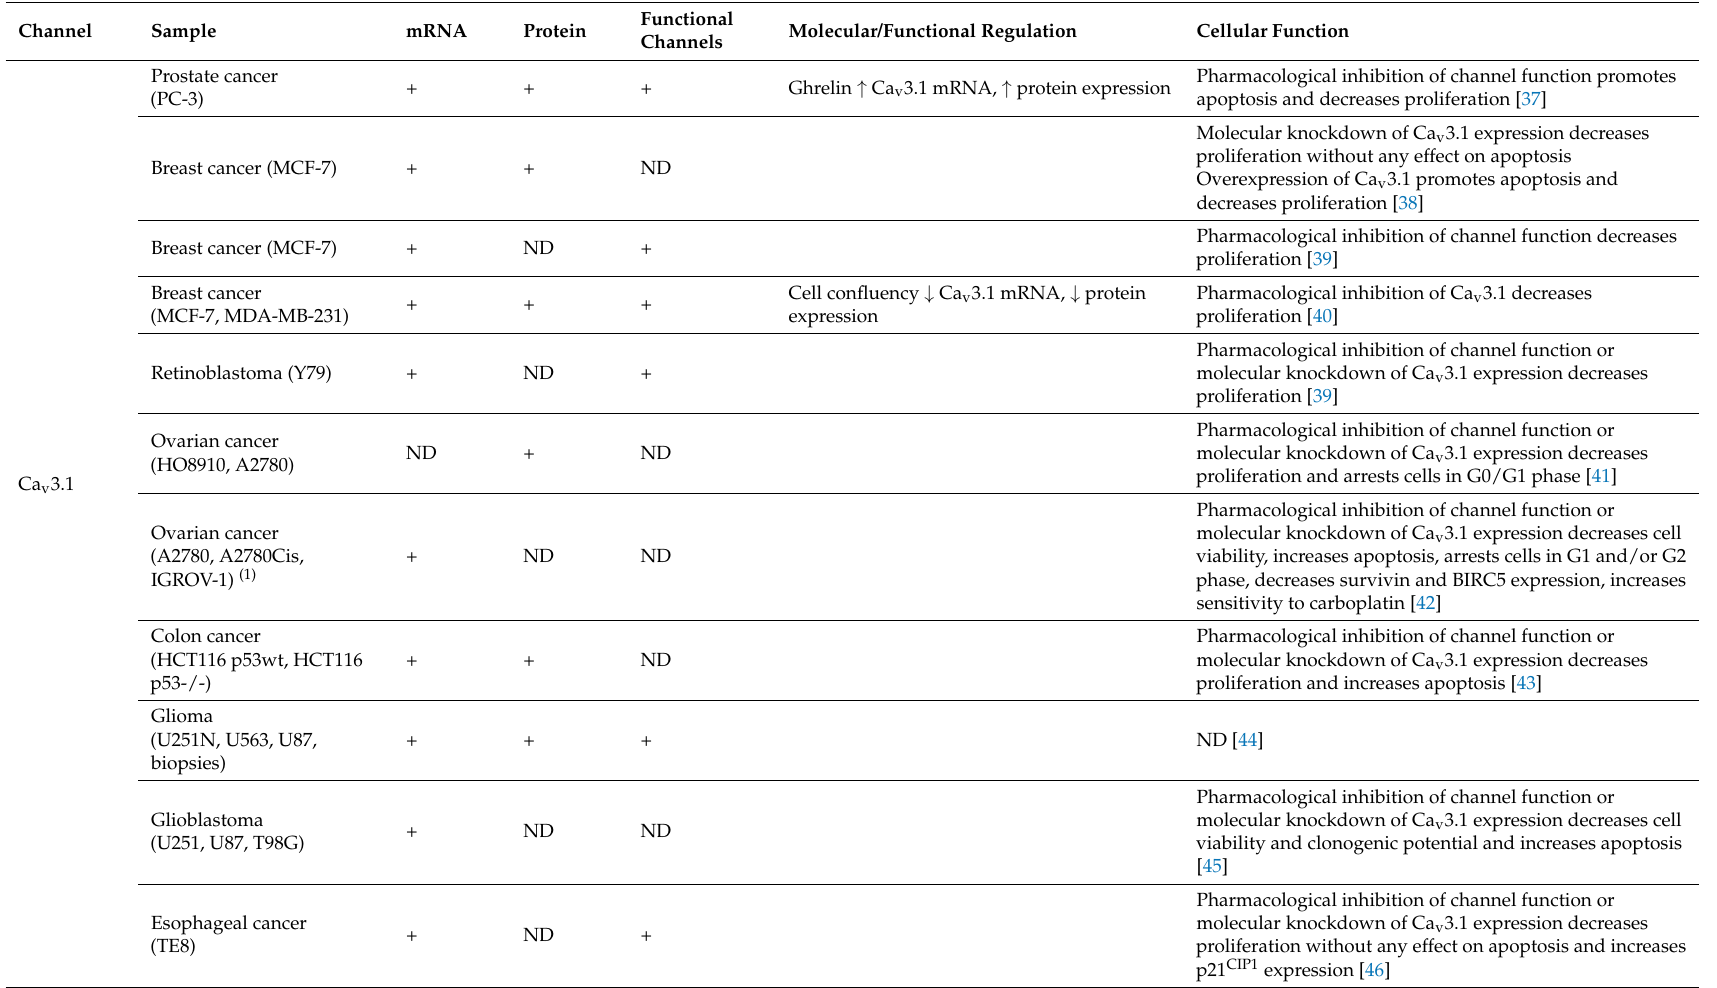
Table 1. Expression of T-type Ca 2+ channel subunits in cancer cells and cellular